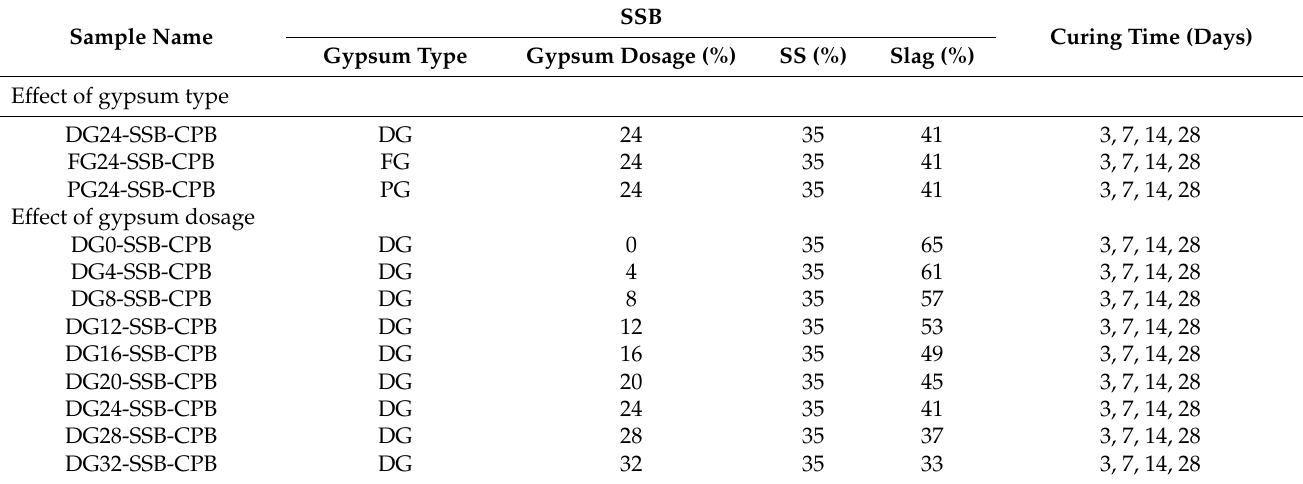
Table 2. Summary of the mixing proportions of the prepared